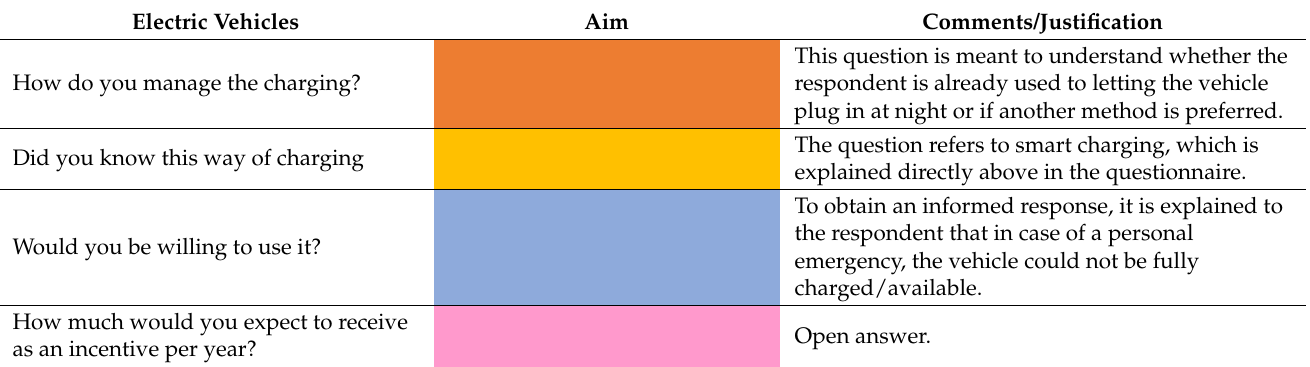
Table 6. Questionnaire—electric vehicles section. Beforehand, the respondent was asked whether